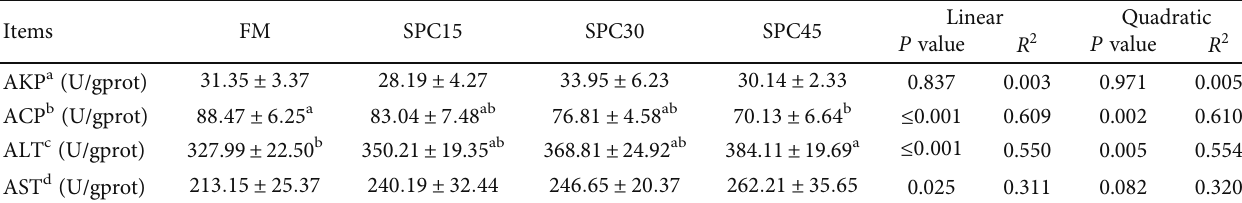
Table 4: The liver enzyme activities of large yellow croakers fed the experimental diets.